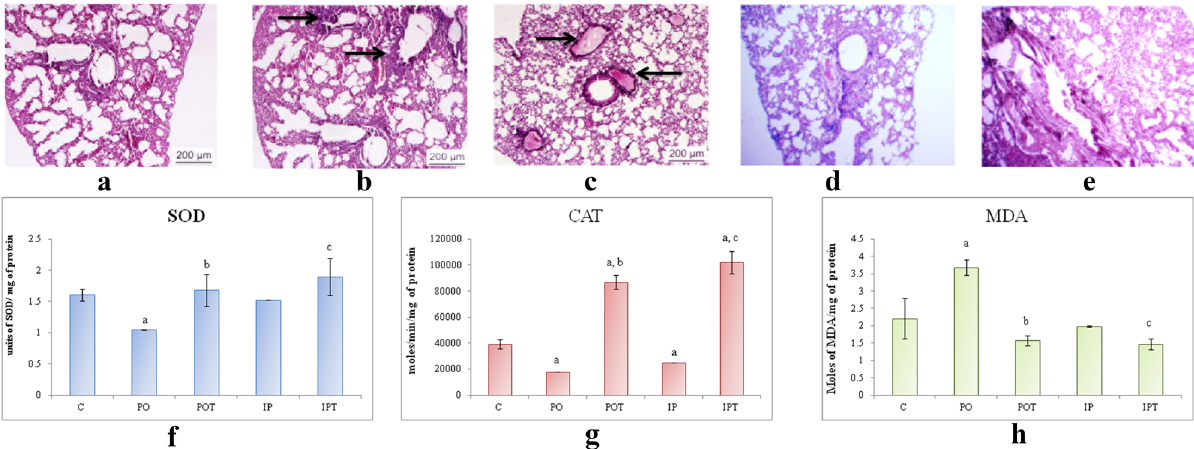
Figure 8. Photomicrographs of TS of lung of ( a ) control (HE, ×100) ( b ) PO-experimental mouse showing inflammation around the bronchiole (HE ×100) ( c ) IP-experimental mouse showing pulmonary oedema in the alveoli (HE, ×100) ( d ) POT-treated mouse (HE, ×100) showing no pathological condition (HE, ×100) ( e ) IPT- treated mouse showing no pathological condition (HE, ×100). ( f ) Comparison of SOD activity in lungs of the control, experimental and treated animals. ( g ) Comparison of CAT activity in lungs of the control, experimental and treated animals. ( h ) Comparison of MDA activity in lungs of the control, experimental and treated animals. The results of biochemical assays are shown in mean ± SE (‘a’ symbolizes p < 0.005 control vs experimental groups, ‘b’ symbolizes p < 0.005 experimental vs treatment groups (PO vs POT) and ‘c’ symbolizes p < 0.005 IP vs